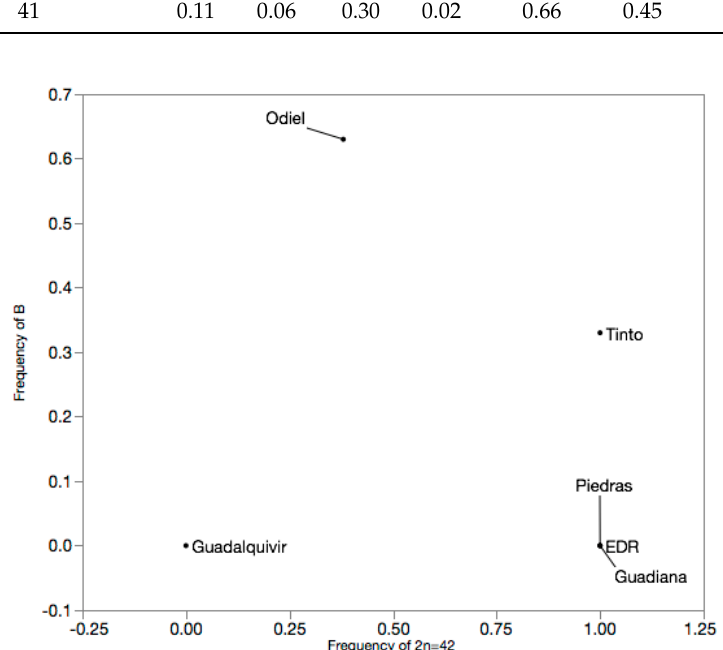
Figure 4. Separation of populations according to frequency of 2n = 42 and B-chromosome.